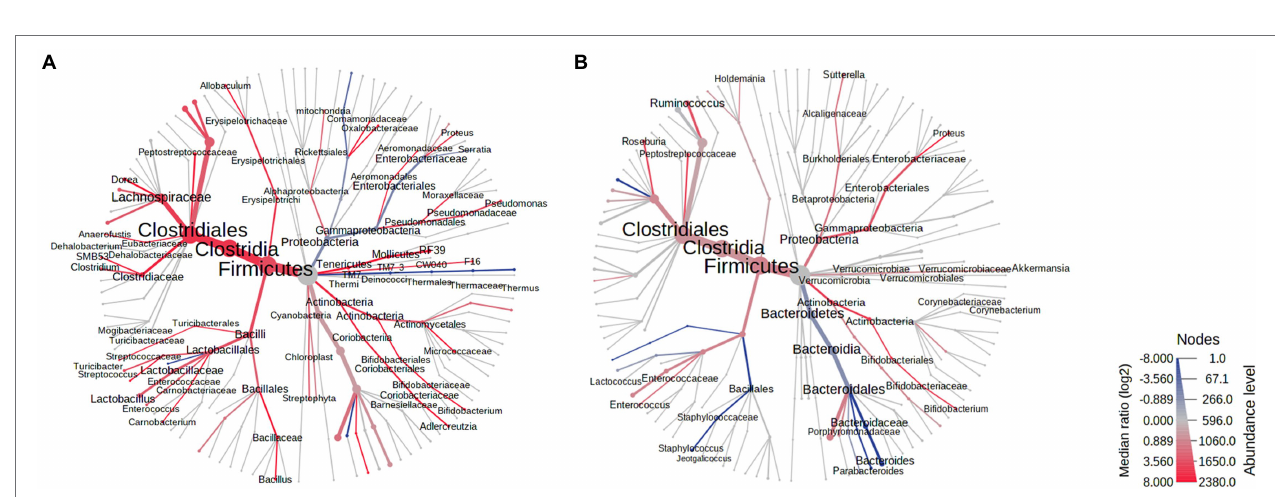
FIGURE 3 | Heat trees of the stool microbiomes in male vs. female antibiotic-exposed rats. (A) Exposed males vs. exposed females on AbxD8. (B) Exposed males vs. exposed females on PAbxD13. Taxa with lower RA in males vs. females are shown in red. Taxa with higher RA in males vs. females are shown in blue. Nodes represent taxonomic levels. Greater line thicknesses and font sizes denote higher